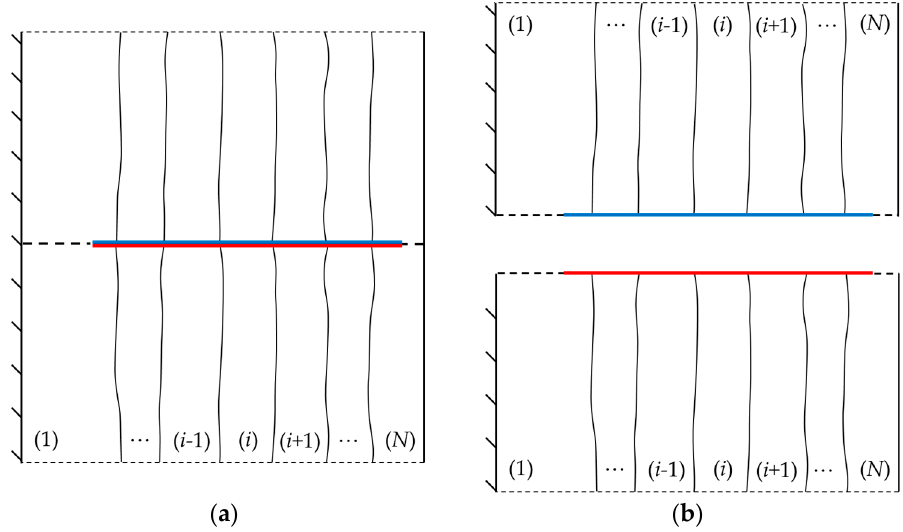
Figure 2. ( a ) Division of the media containing a slit-like crack; ( b ) results of the division. We indicate the upper and lower parts of each layer after the cutting by the superscripts ’ and ‘’, respectively (Figure 3). The dividing also results in the horizontal interfaces, denoted by I , in the bottom and top layers, as shown in Figure 3a,c.